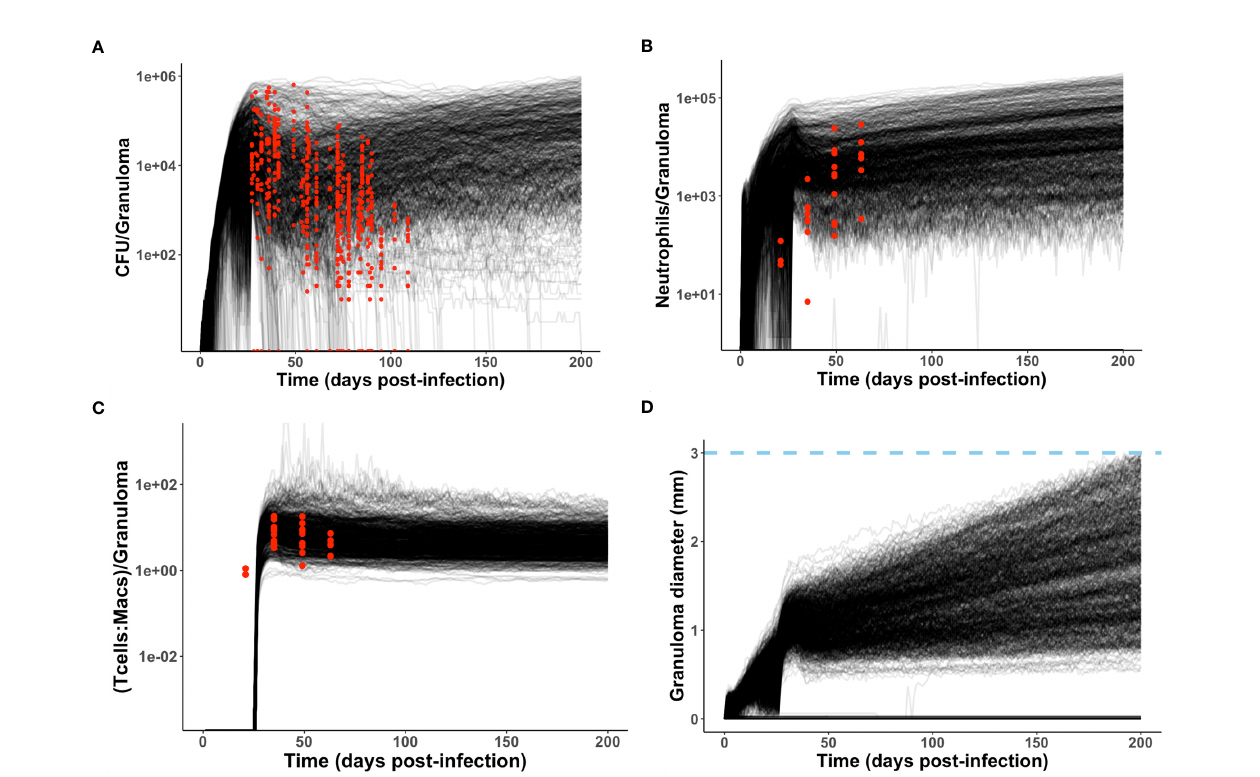
FIGURE 4 | Model produces simulated data that matches NHP data. We compare simulated data from the neutrophil-speci fi c parameter set with experimental datasets obtained from (34) (see Methods). Red = experimental data, black = simulated data. (A, C, D) Number of bacteria (CFU) and T cell to macrophage cell count ratio were the primary temporal experimental data used in model calibration; granuloma diameter (in mm) served as an additional screening tool. (B) Neutrophil cell count data was used for model validation.